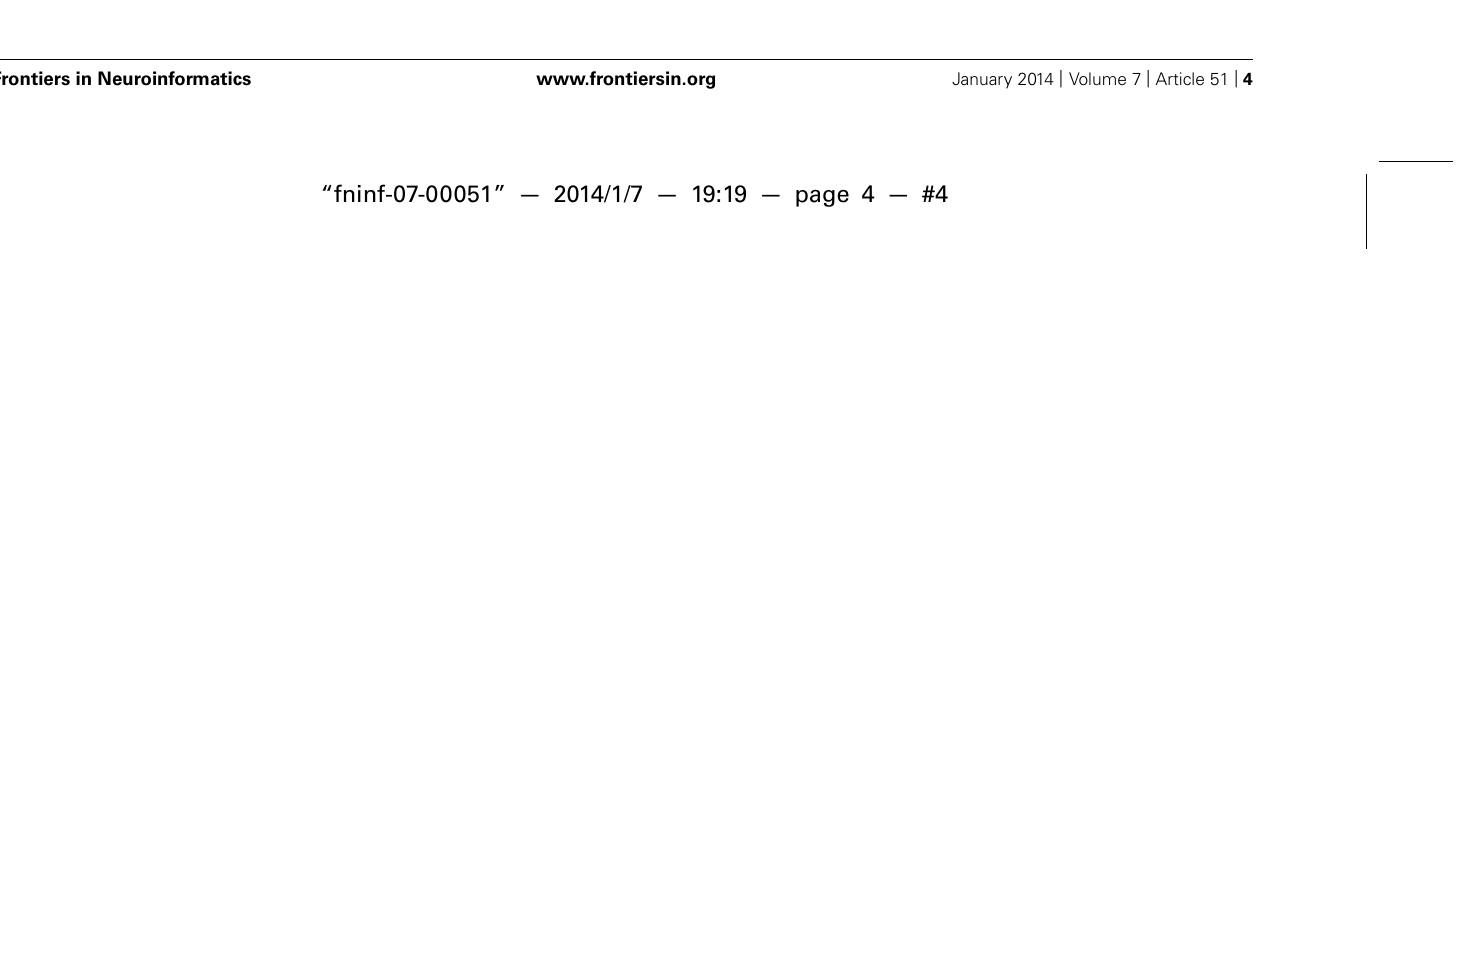
saved DWI volume. (B) Axial and coronal view of DTI color fractional anisotropy (FA) volume.The large area of blue in the left frontal and temporal lobes indicates that a dominant direction artifact remains after DTIPrep quality control.Thus this artifact was too large to correct and this participant was excluded from